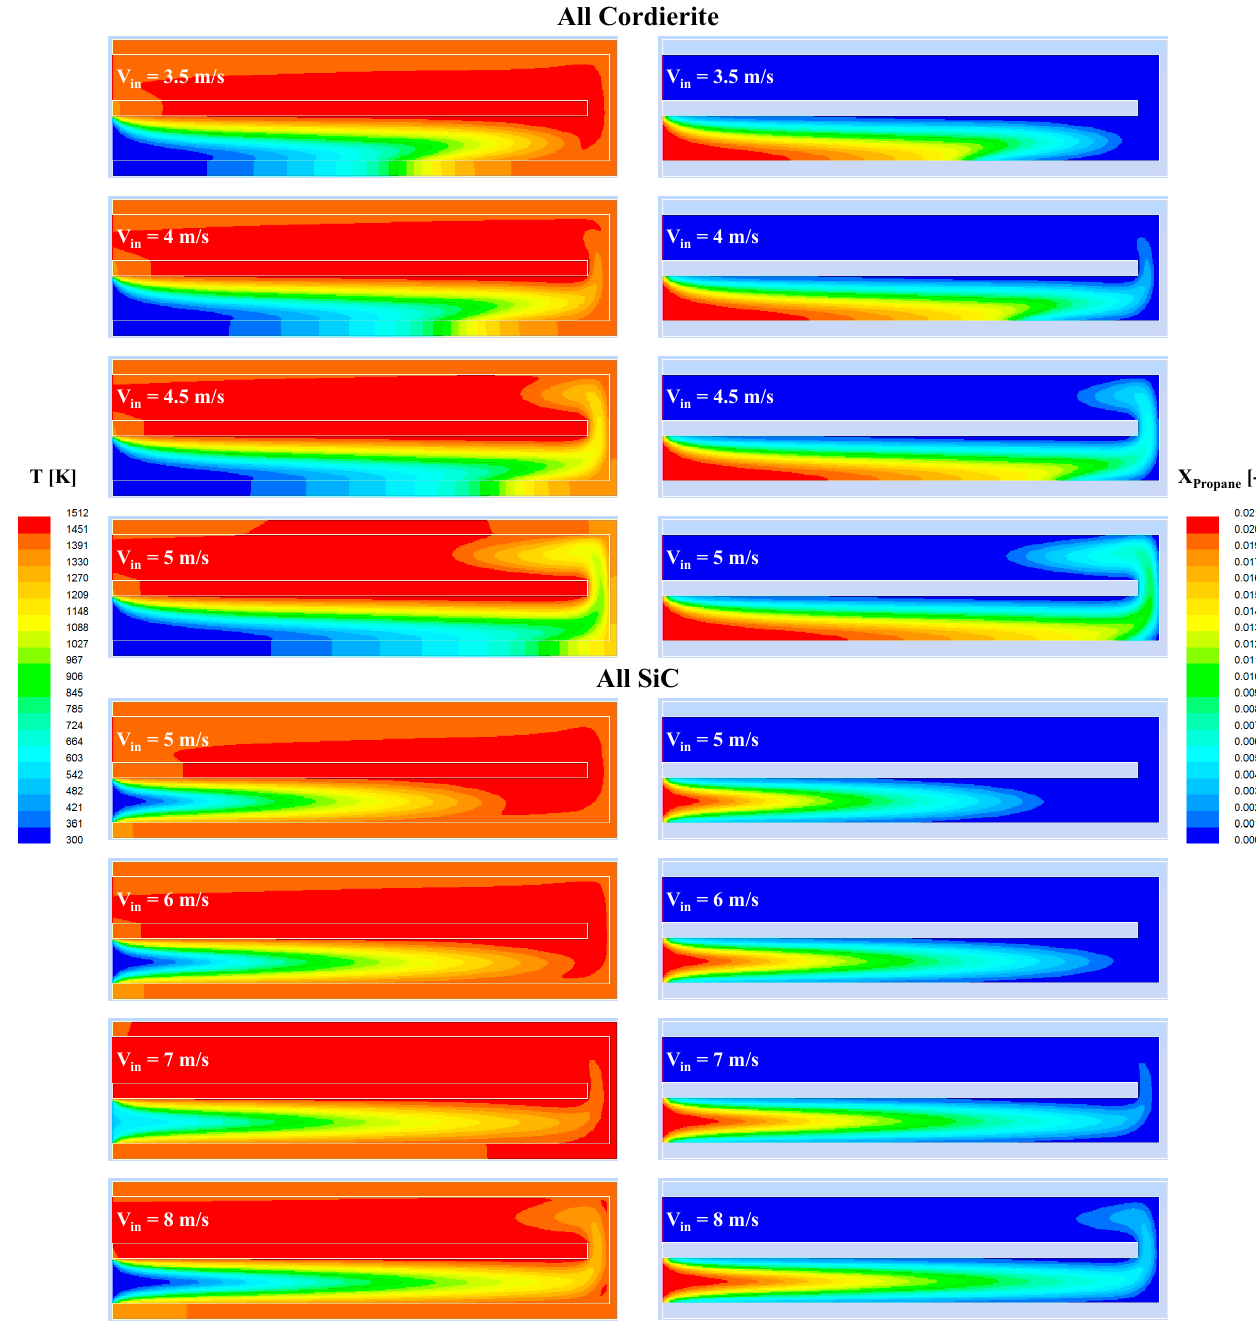
Figure 6. Maps of temperature, T, and propane mole fraction, X Propane , at different values of V in : All Cordierite; All SiC. A scaling factor equal to 2 was used to scale the computational domain along the transverse direction.